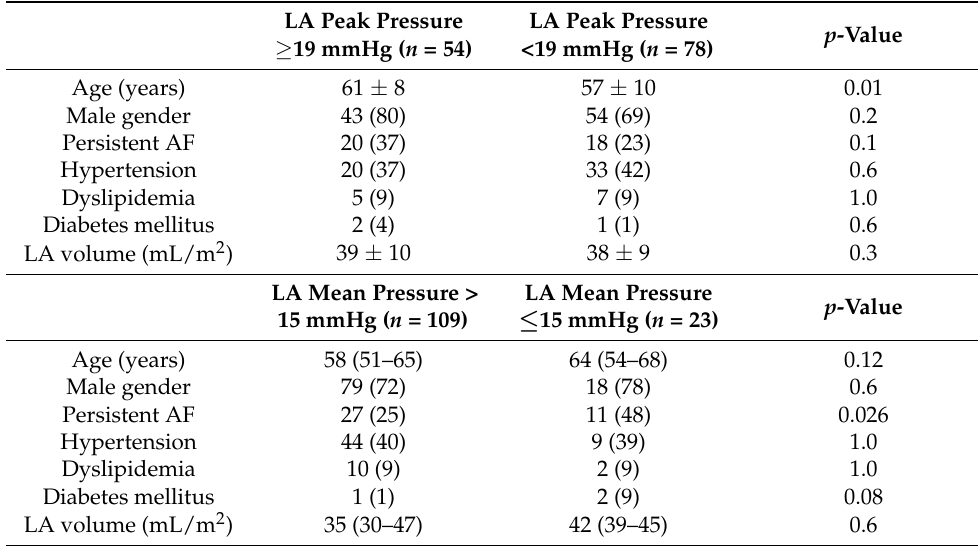
Table 2. Comparison of clinical characteristics between patients with high left atrial pressures (peak of left atrial pressure ≥ 19 mmHg and mean pressure >15 mmHg).